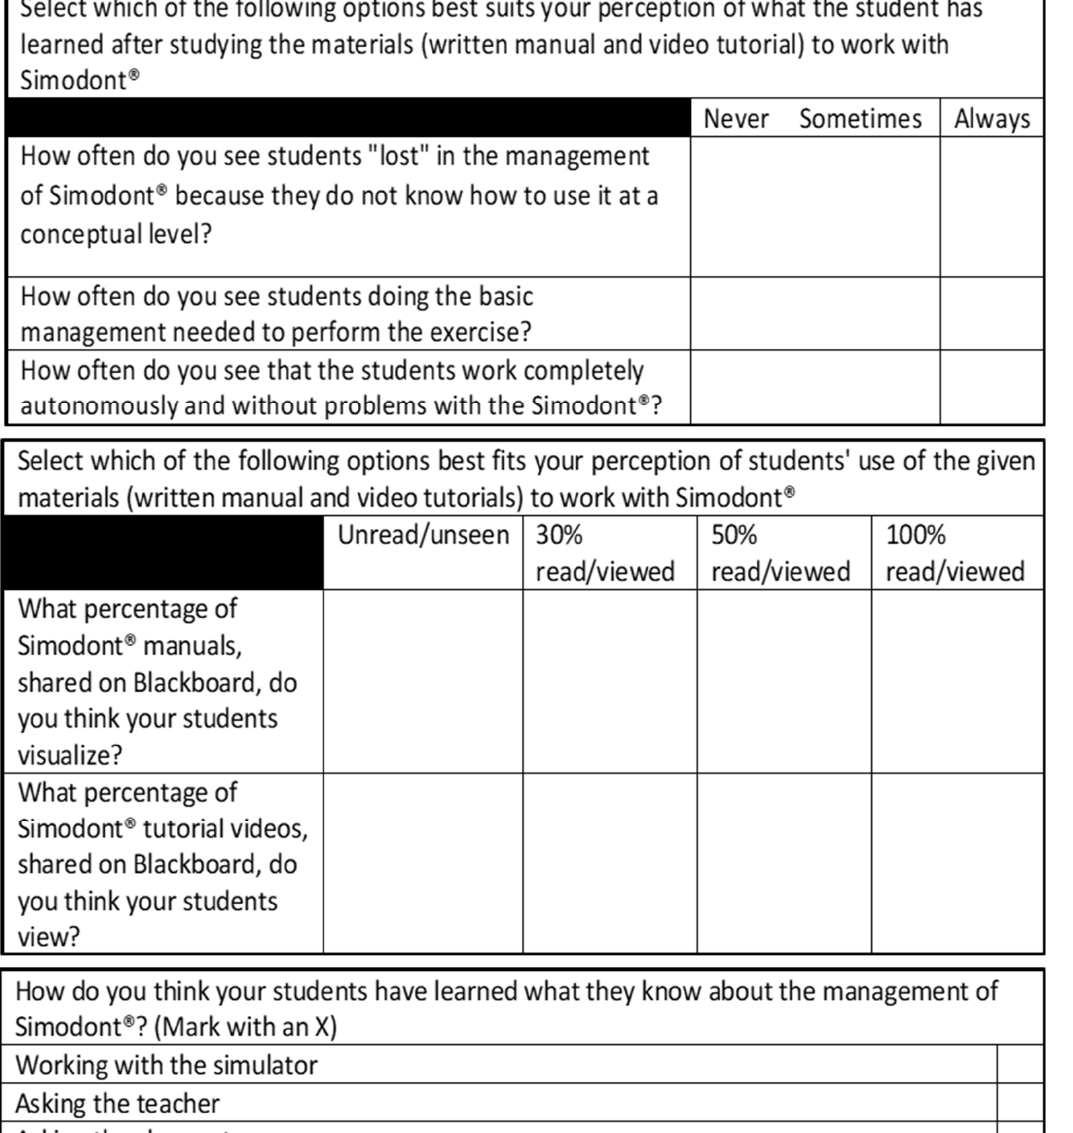
Table 1. Description of dependent variables. Variable